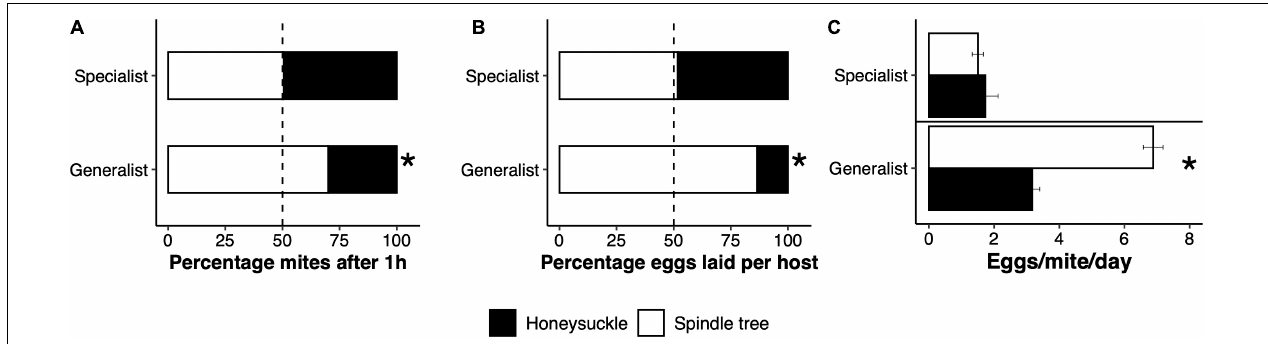
FIGURE 4 | Adaptive avoidance of honeysuckle by generalist spider mites. In a two-choice experiment, generalist Tetranychus urticae females significantly preferred to feed on spindle tree after probing (A) , and to oviposit most of their eggs on this host (B) , rather than on honeysuckle. In a no-choice experiment, generalist mites laid significantly fewer eggs on honeysuckle compared to spindle tree (C) . Honeysuckle specialist mites did not show a preference for either host, neither did they lay more eggs on any particular host. Stars represent a significant difference from a 50:50 probability in (A,B) , and a significant difference in the mean egg production between hosts in (C)